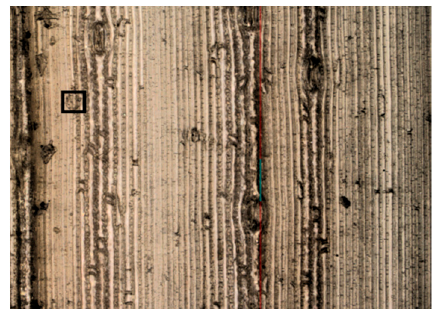
Figure 11. Original micro-structure of the wheat stalk.